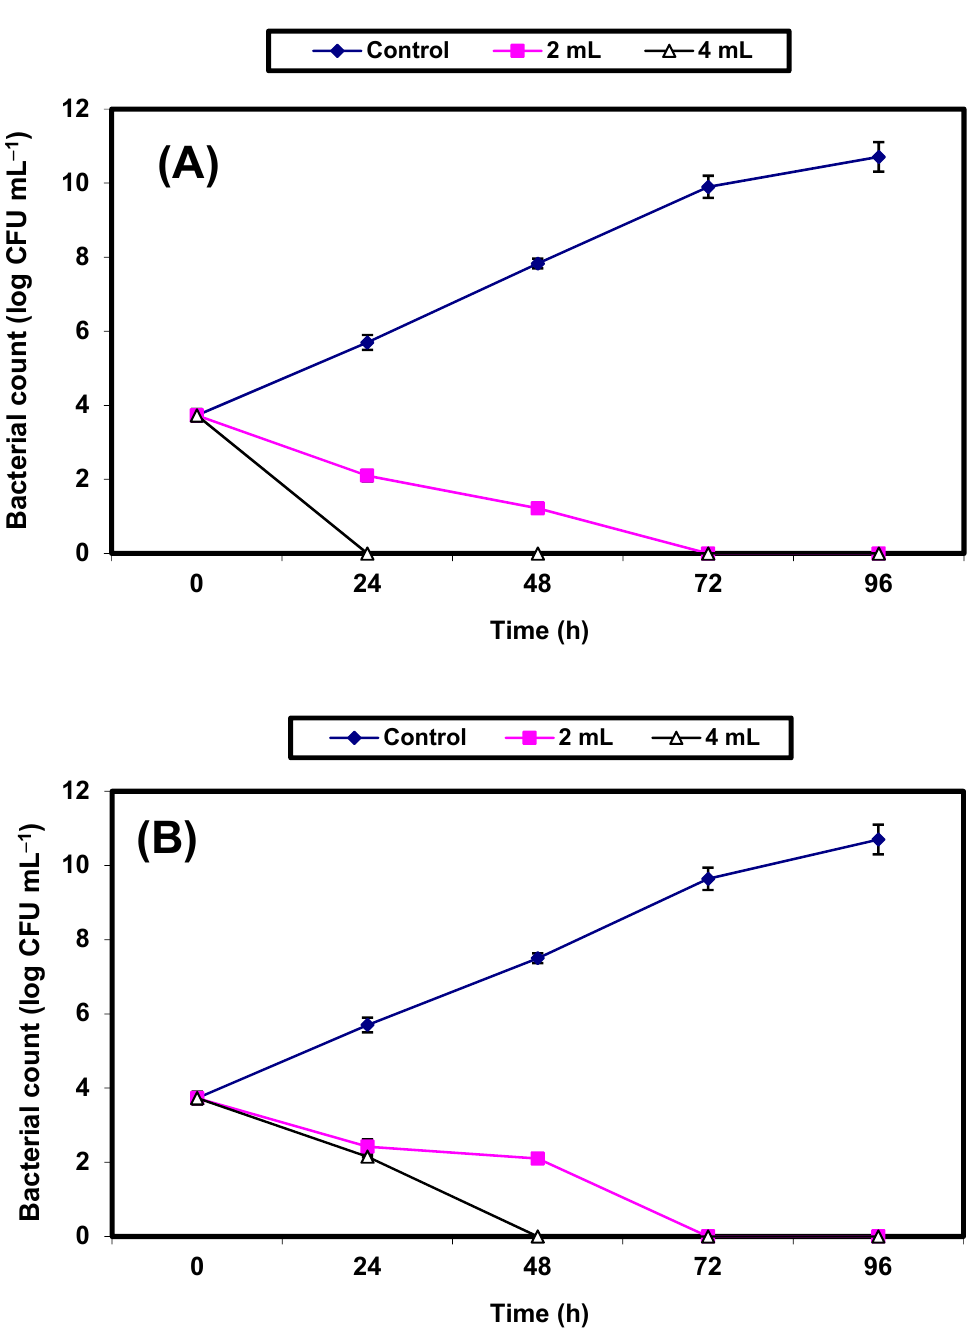
Figure 4. Inhibition of both S. aureus ( A ) and E. coli ( B ) in apple juice. Symbols ♦ , ■ , ∆ refer to untreated control samples and juice samples treated with 2% and 4% KFB, respectively.